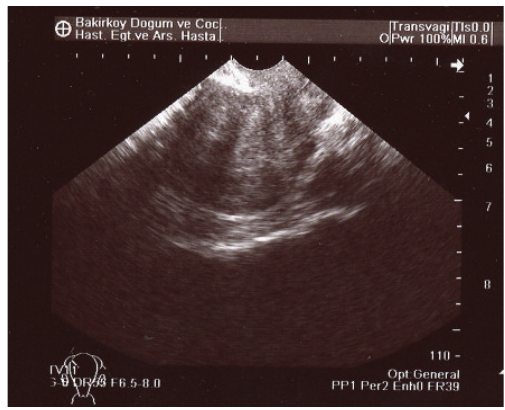
Figure 1: Transvaginal pelvic ultrasound showed an abnormal en- dometrial echo pattern. The endometrium was heterogenous and had irregular surface.